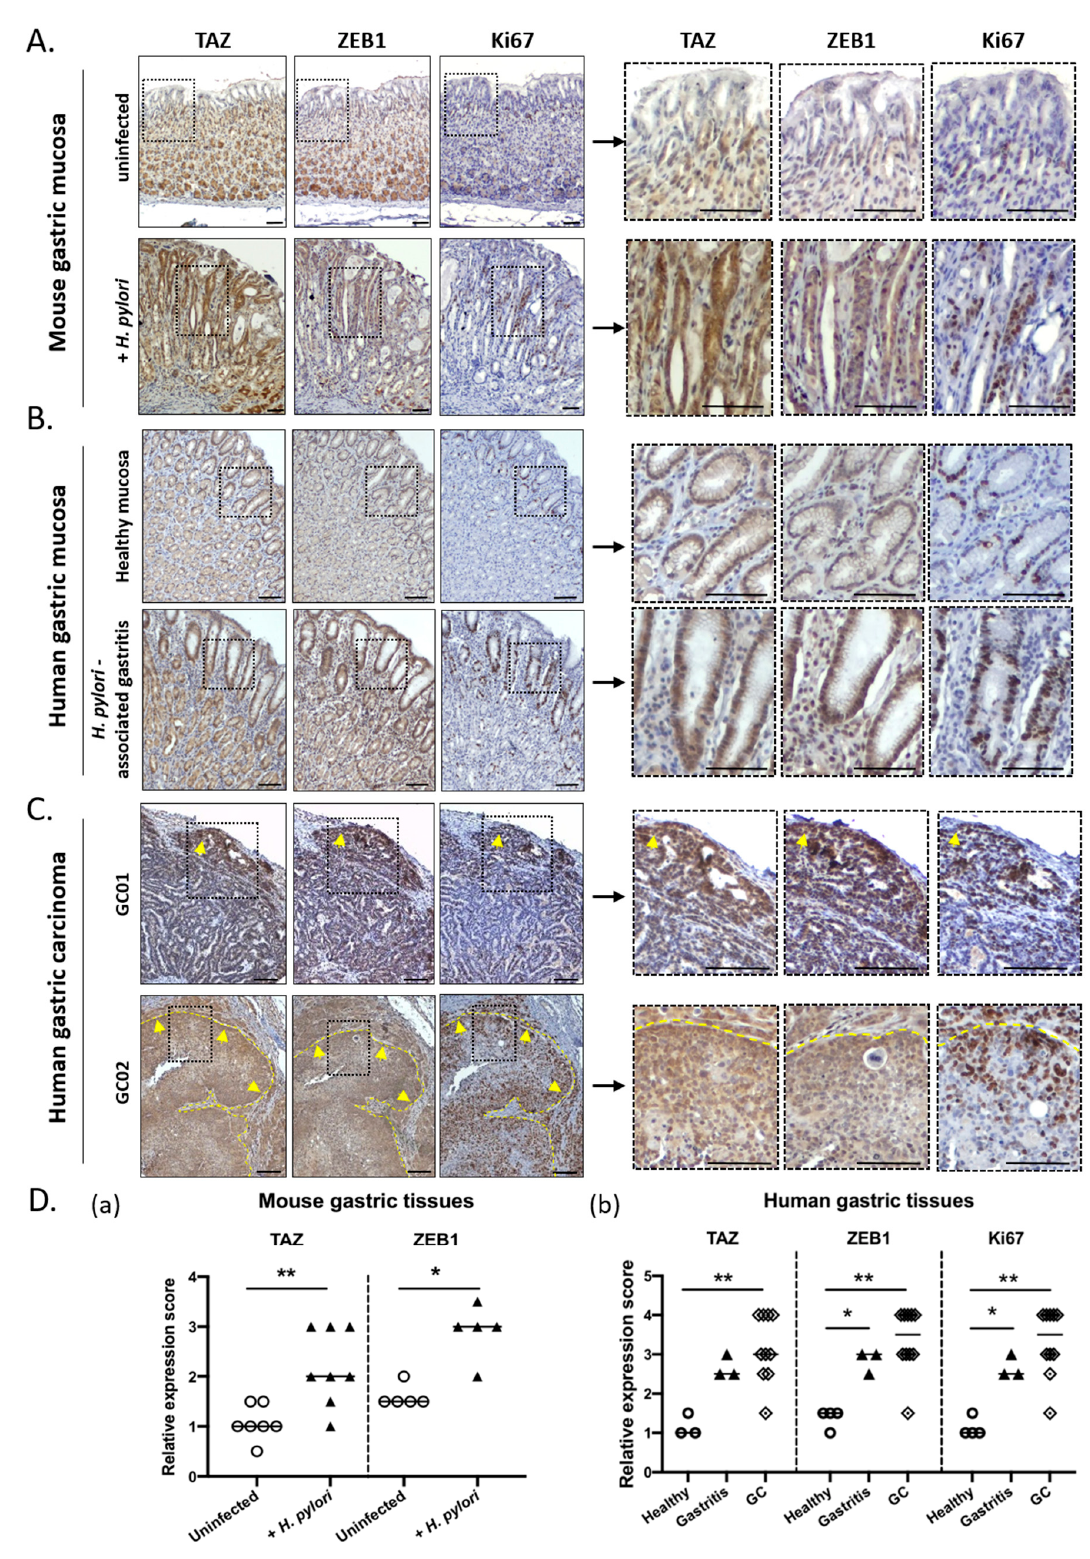
Figure 3. TAZ and ZEB1 were co-upregulated in gastric epithelial cells of H. pylori -infected mice and patients and in human gastric carcinoma. Representative images of the immunohistochemistry staining (dark brown) of TAZ, ZEB1, and Ki67 on serial tissue sections. ( A ) Representative images of the